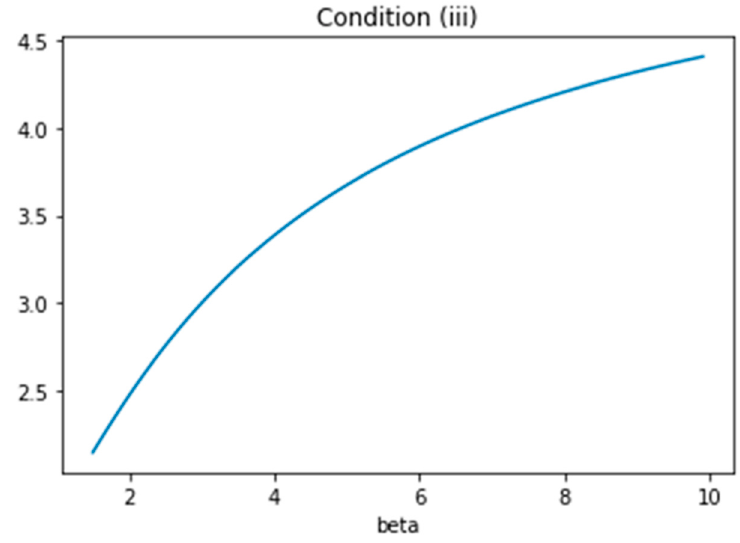
β —condition (iii).